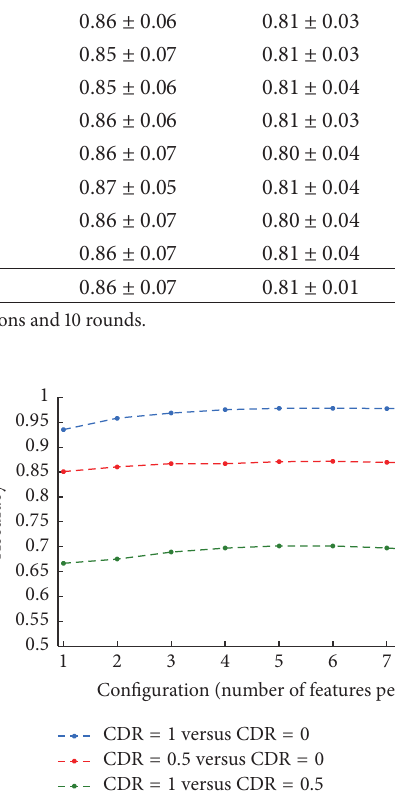
Table 8: Performance of ML (accuracy) in the inner and outer loops for each of the 10 rounds (averaged across 100 iterations). Results are reported for CDR = 1 versus CDR = 0, CDR = 0.5 versus CDR = 0, and CDR = 1 versus CDR = 0.5 using a linear kernel and the feature reduction guided by the neuropsychologists.